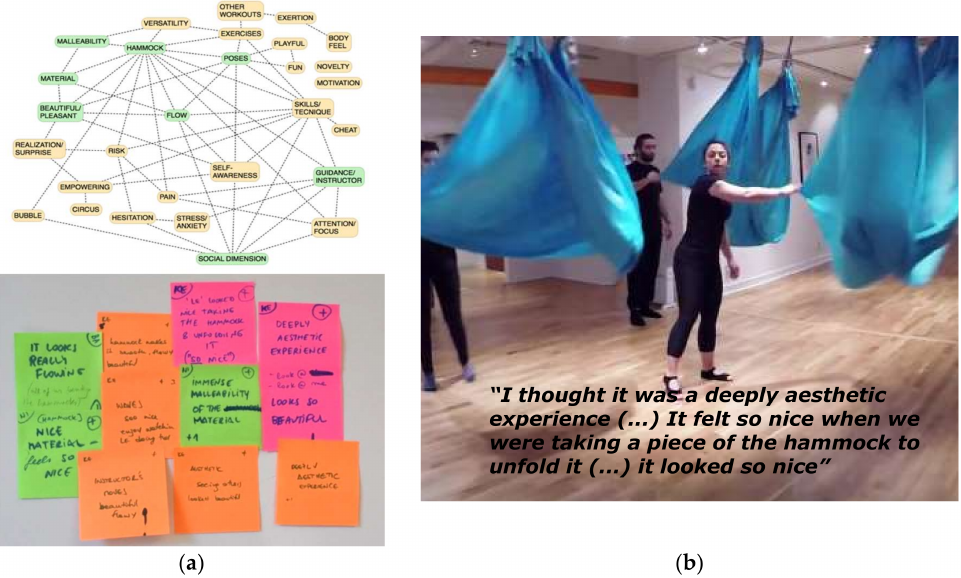
Figure 14. Aesthetic Performance . ( a ) The corresponding analysis’ categories, with the ones that the SomaBoard relate to ( malleability, material, beautiful/pleasant, hammock, flow, poses, social dimension and guidance/instructor ) highlighted, and a picture of the original post-its. ( b ) SomaBoard depicting the deep aesthetic experience of the group’s unfolding and waiving the hammocks.